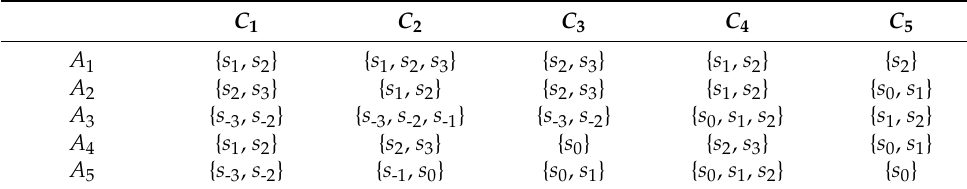
Between medium and good Between medium and very good Between good and very good ) . S ij